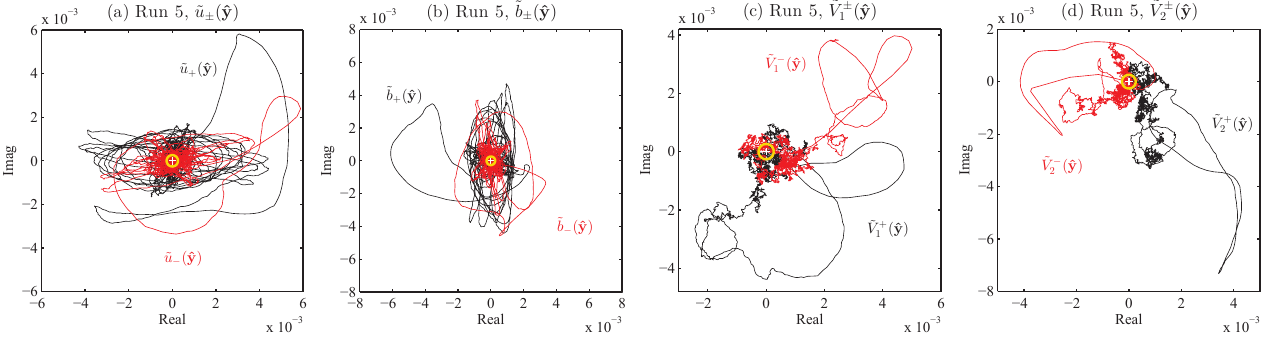
( ˆ y , t ) [ ˜ b ( ˆ y , t ) + ˜ u ( ˆ y , t )] 1 ∼ ± ±